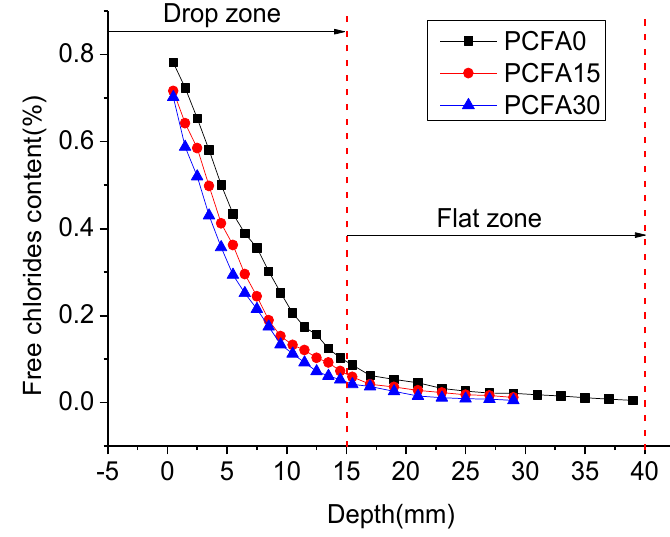
Figure 2. Free chloride deposition of concrete with different fly ash replacement ratios.